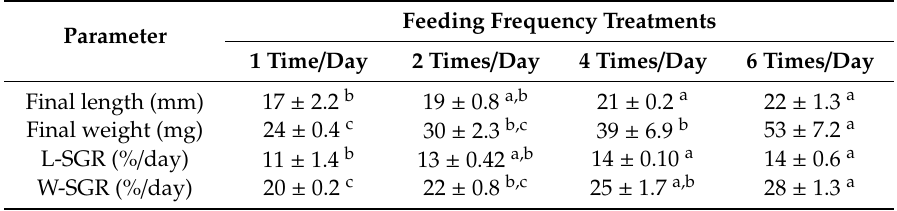
Table 7. Growth performance of P. hypophthalmus larvae after 10 days of development under different feeding frequency treatments.